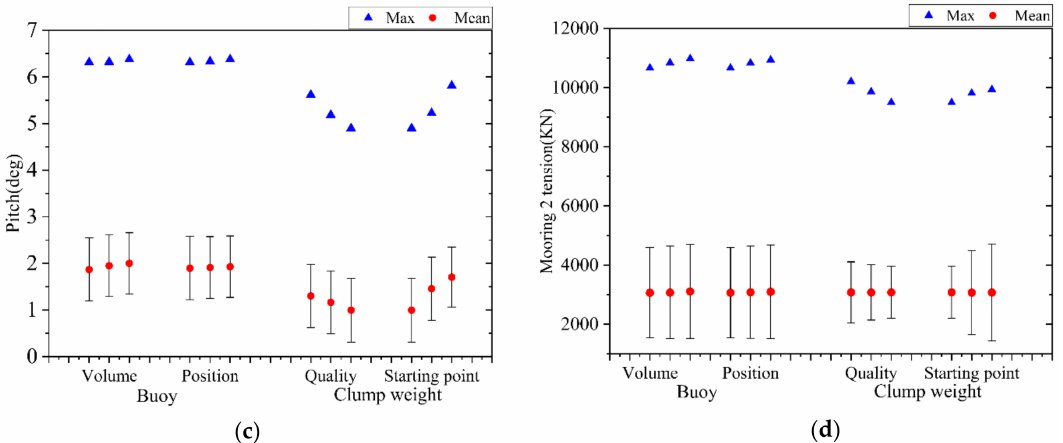
Figure 7. Comparison diagram of overall response of wind turbine with separate accessories. ( a ) Surge. ( b ) Heave. ( c ) Pitch. ( d )